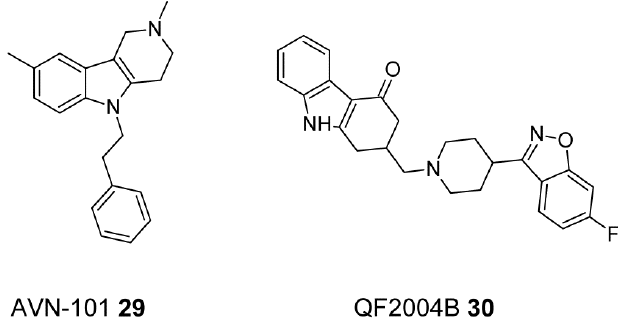
Figure 15. Multi-target ligands of aminergic GPCRs as potential antipsychotics.